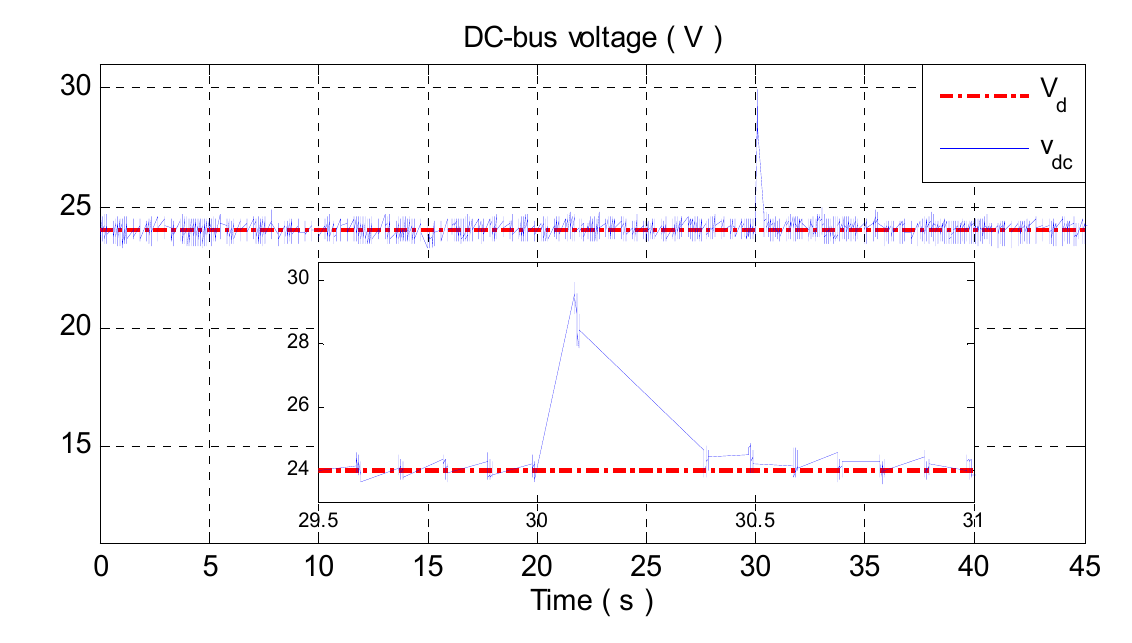
Figure 18. Voltage measurement of v dc and its reference signal V d .